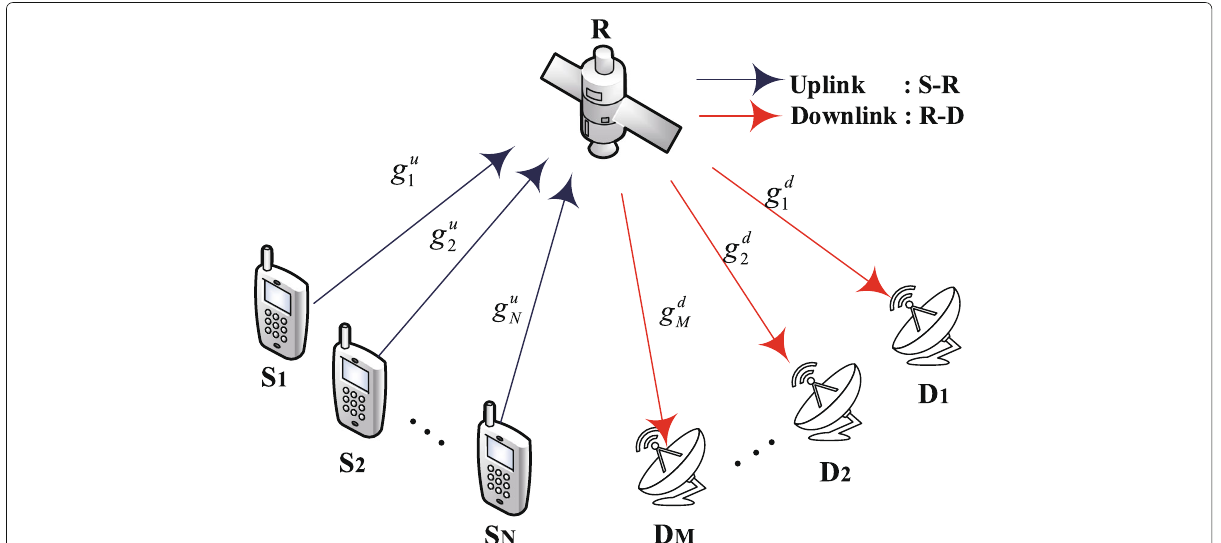
Fig. 1 System model of the multiuser dual-hop satellite relaying. The figure consists of N source ESs termed as source (S), M destination ESs termed as destination (D) and a satellite relaying